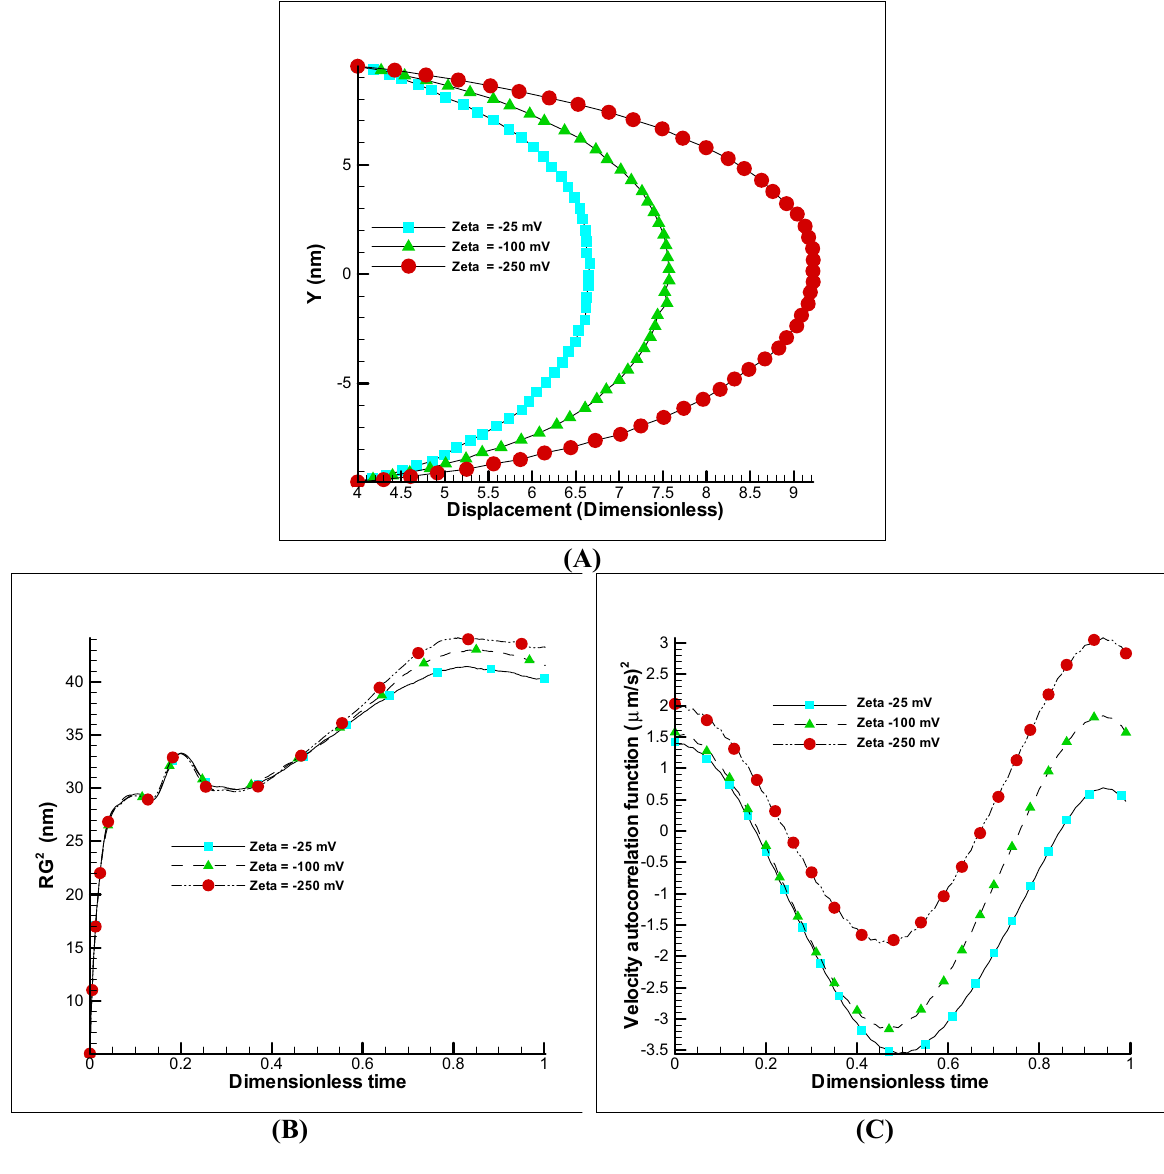
Figure 5. Changes of zeta potential on EOF and polymer membrane. Different displacement of polymer membrane by changing the zeta potential, kH = 8, E0 = 250 V/m ( A ). Variation of radius of gyration and VACF over dimensionless time (t/t max ) by changing the zeta potential ( B , C